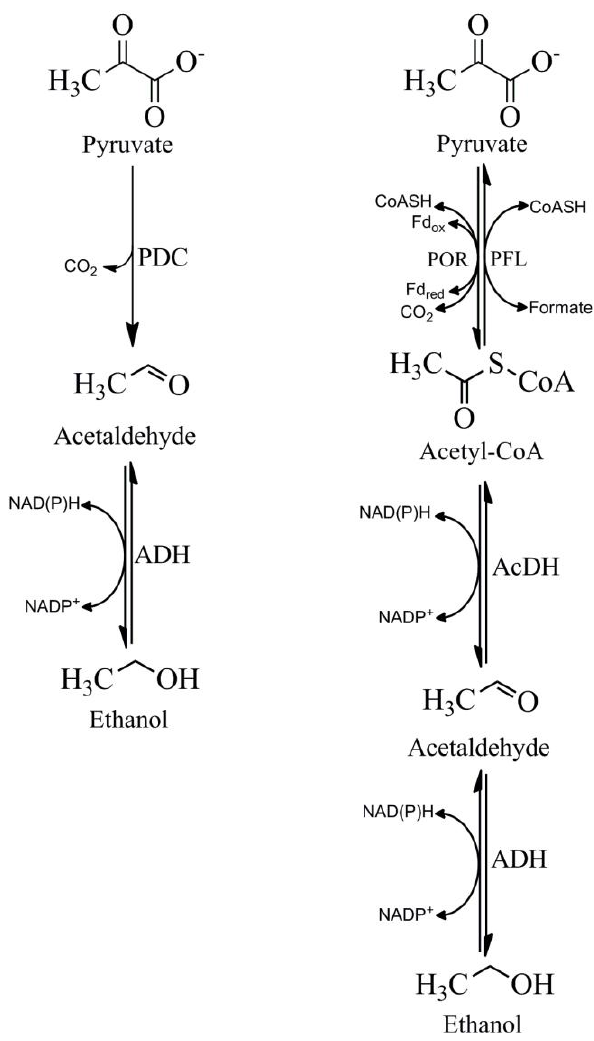
Figure 1. Two pathways of ethanol production from pyruvate. POR; Pyruvate ferredoxin oxidoreductase; PFL; Pyruvate formate lyase, AcDH; Acetaldehyde dehydrogenase, ADH; Alcohol dehydrogenase, PDC; pyruvate decarboxylase; CoASH; coenzyme A, Fd oxidized ferredoxin, Fd ; reduced red